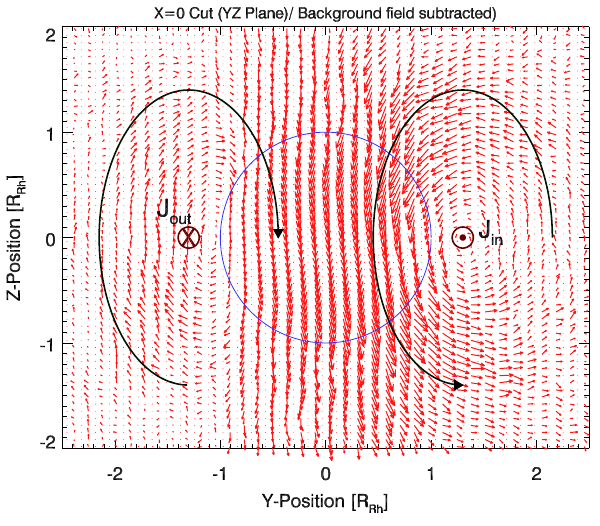
Fig. 5. Magnetic field perturbations in a the yz-plane, just behind Rhea. The direction of the plasma flow (and the wake) points out of the page. Here the background field has been subtracted to enhance visibility of the compression and decompression regions of the mag- netic field. The blue circle indicates the location of Rhea’s geomet- rical shadow. The length of the arrows (arbitrary units) is indicative of the perturbation amplitude. The peak amplitude of the residual B y in this simulation is about 1.5 nT. The closed magnetic field loops and the inferred current flow vectors are also sketched. Sim- ilar instructive diagrams of the residual magnetic field have been constructed based on data from laboratory simulations of the solar wind interaction with unmagnetized or weakly magnetized obsta- cles (Podgorny et al., 1982; Dubinin et al., 1977).